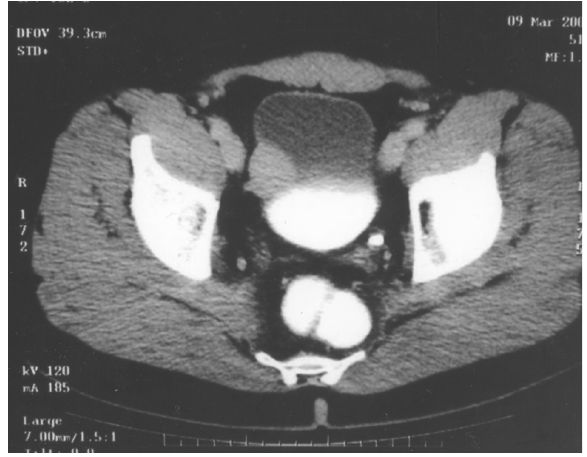
Figure 1 – Pelvic computerized tomography, showing tumor in right lateral wall of the